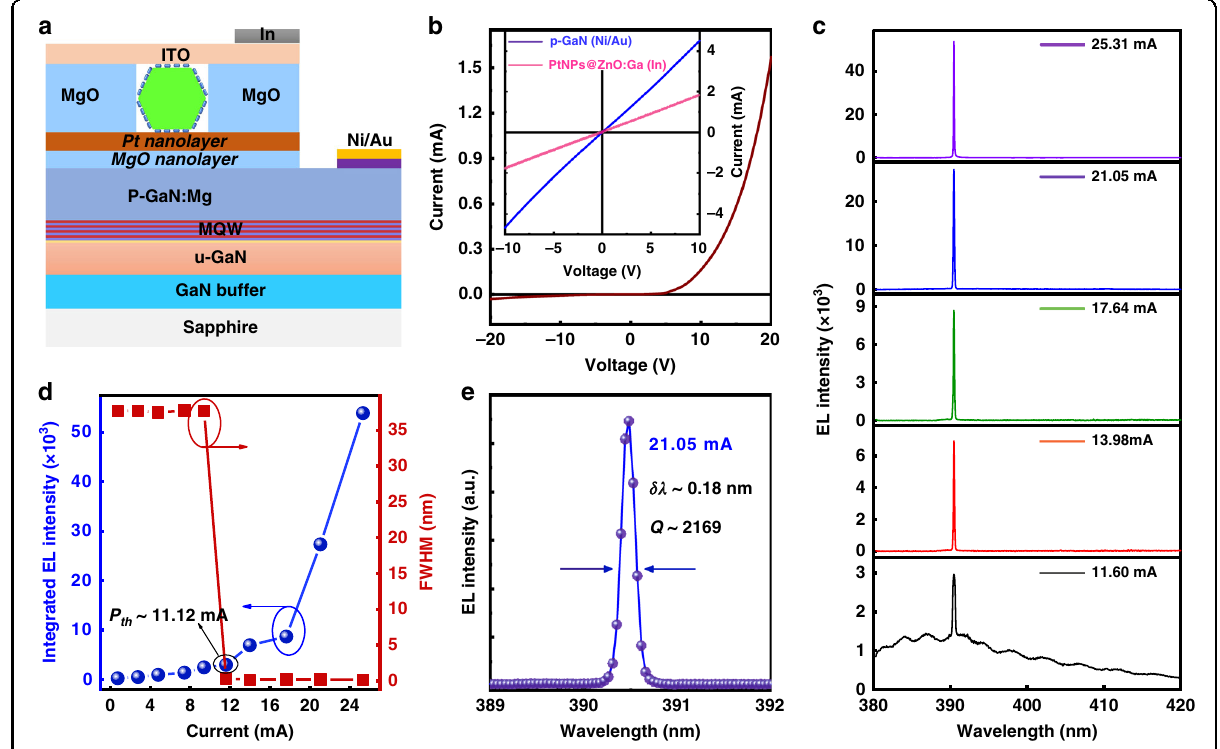
Fig. 1 CW operation of EL characterization of as-constructed n-PtNPs@ZnO:Ga MW/Pt/MgO/p-GaN heterojunction device. a Schematic illustrating the cross-section of the laser device architecture based on the n-PtNPs@ZnO:Ga MW/Pt/MgO/p-GaN heterojunction. In the device con fi guration, ITO and Ni/Au working as electrodes are responsible for the current injection. b I – V curve of the fabricated single MW heterojunction emission device. Inset: the I – V curves of Ni/Au electrode contacted to the p-type GaN fi lm, and a single PtNPs@ZnO:Ga MW, respectively. c Current- dependent EL spectra of the as-fabricated single MW-based LED, as the injection current is increased from 11.6 to 25.31 mA. d Variations of the integrated EL intensity and spectral FWHM as a function of injection current, showing a lasing threshold of 11.12 mA. e EL spectrum via Lorentz fi tting at the input current of 21.05 mA, providing the FWHM of the lasing peak δλ ~ 0.18 nm, and the corresponding Q -factor value is calculated